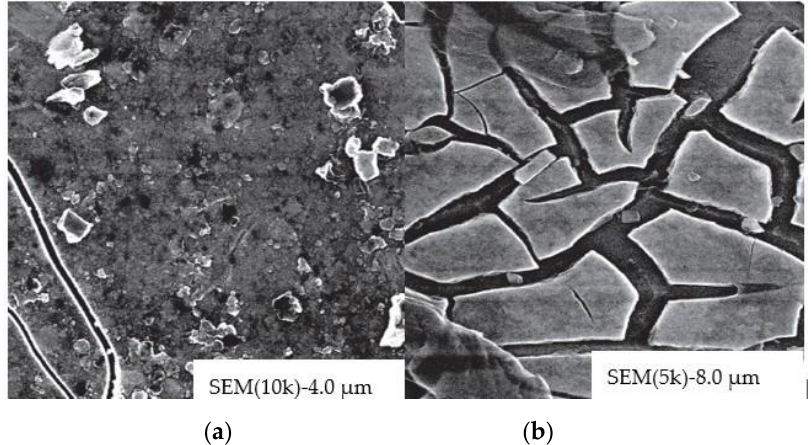
Figure 32. Nanostructured films obtained by electrochemical deposition: ( a ) WO 3 (GO 2ml ); ( b ) WO 3 (GO 1ml ) [135].